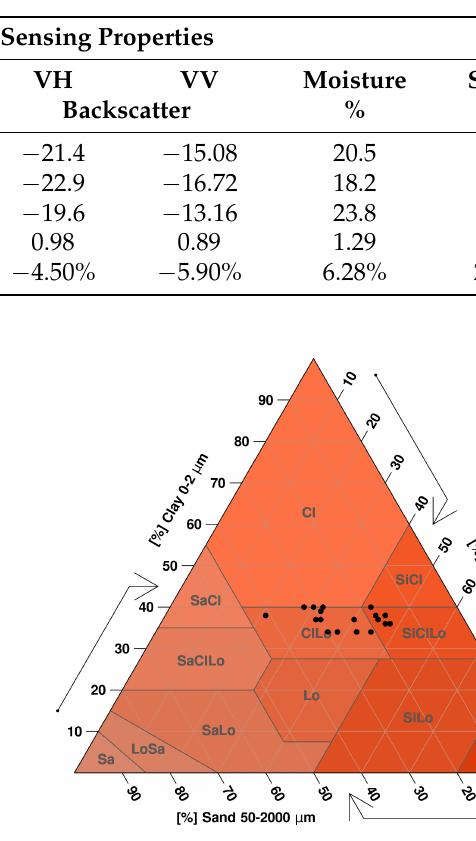
Figure 5. Ternary plot of soil texture (USDA) on the sampling point set. Soil texture classes are